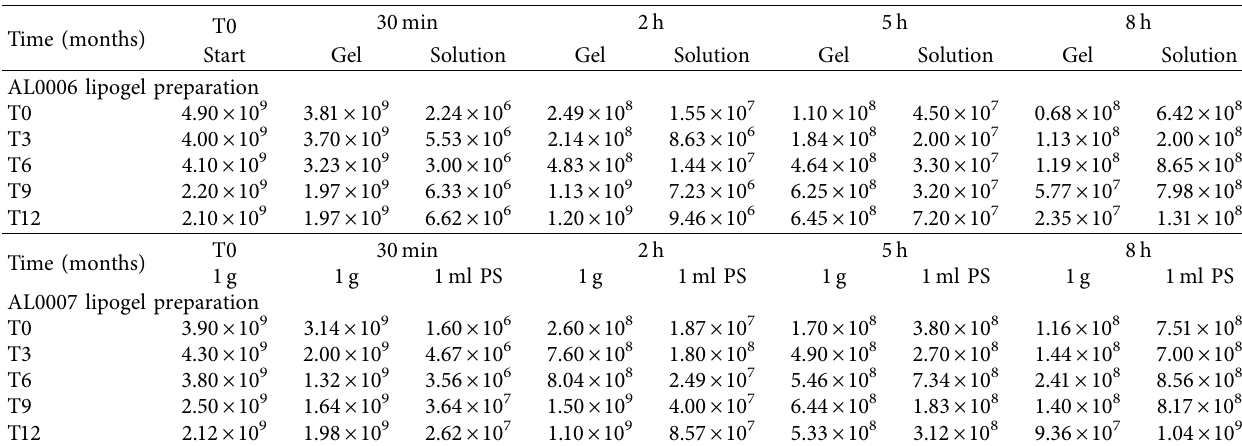
Enumerations of bacteria on lipogels AL0006 (a) and AL0007 (b) and their release in physiological solution. Time T0 is referred to the quantity of lactobacilli present in the lipogels, while time points 30min, 2, 5, 8h refer to the quantity of bacteria remaining in the 1g lipogel (Gel) or released in solutions (1g/ml) (solution) after each incubation time. Bacterial load and release from lipogels to physiological solution (PS) were evaluated after 3 (T3), 6 (T6), 9 (T9), and 12 (T12) months on a shelf at room temperature. Values are reported as mean. The standard deviation (SD) ranged between 0.1 and 0.3 for all the means and was not reported.